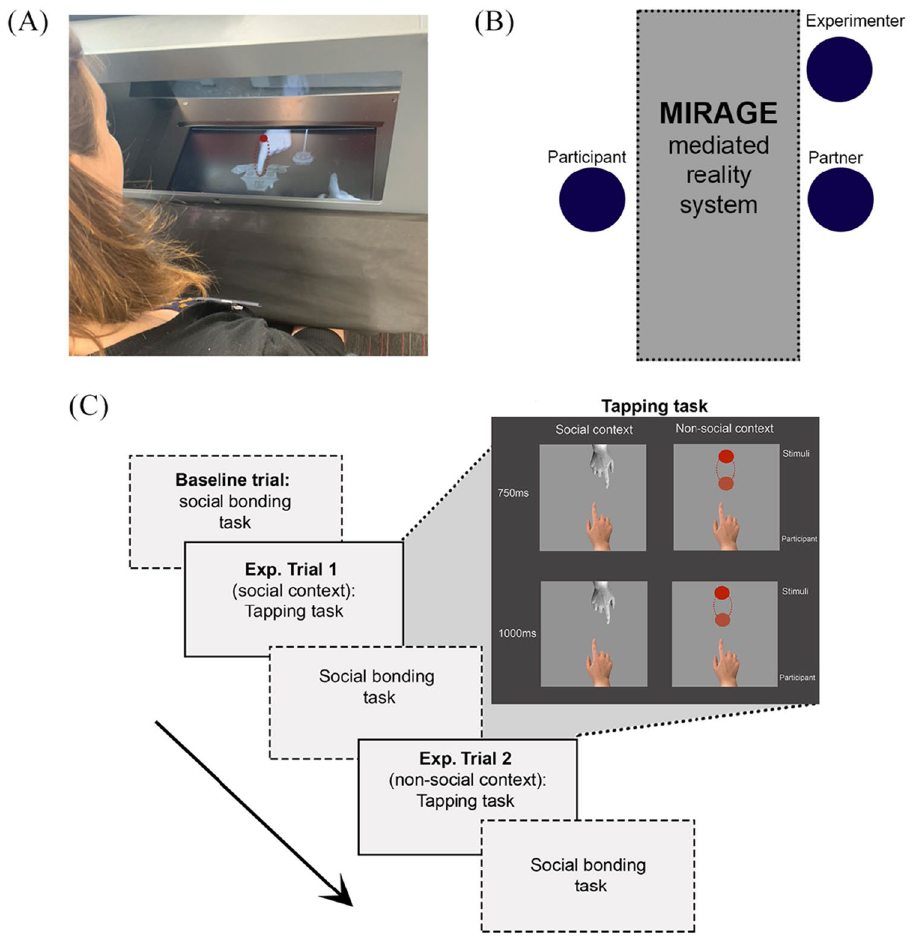
Figure 1. Schematic of the study procedure. ( A ) Participant view of the MIRAGE window, with their hand on the bottom right of the window and the social stimulus (partner’s hand) and non-social stimulus (red ball) opposite. The cartoon house and animal were used in the child-friendly dummy task. ( B ) Study set-up. The partner sat in the same position in both the social and the non-social context conditions. ( C ) Procedure of Study 1 and Study 2 (order of context and stimulus tempo counterbalanced across participants). In Study 1, participants completed two social context trials at each tempi and two non-social context trials at each tempi, therefore a total of four tapping trials. In Study 2, participants only completed one social trial and one non-social trial, with the tempo varied between trials (e.g. social at 750 ms and non-social at 1000 ms) for a total of two tapping